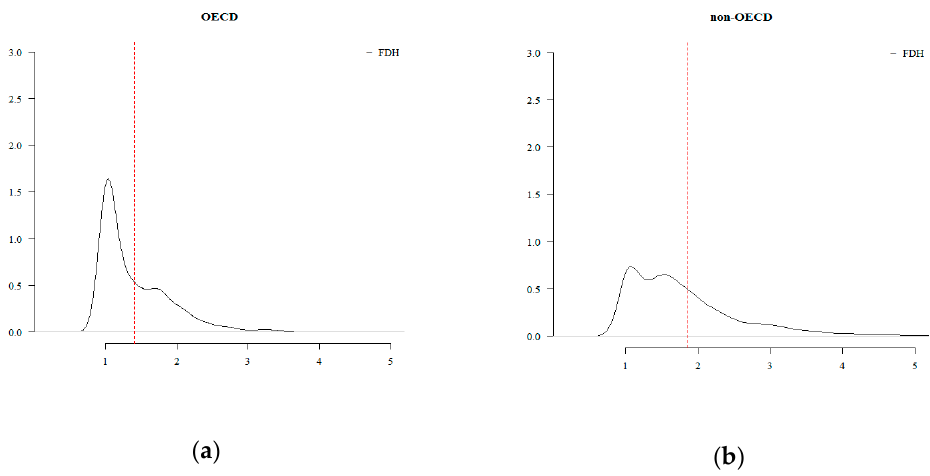
Figure 1. Density plots of unconditional countries’ production efficiency levels derived from the FDH estimator: ( a ) FDH production efficiencies of OECD countries; ( b ) FDH production efficiencies of the non-OECD countries.